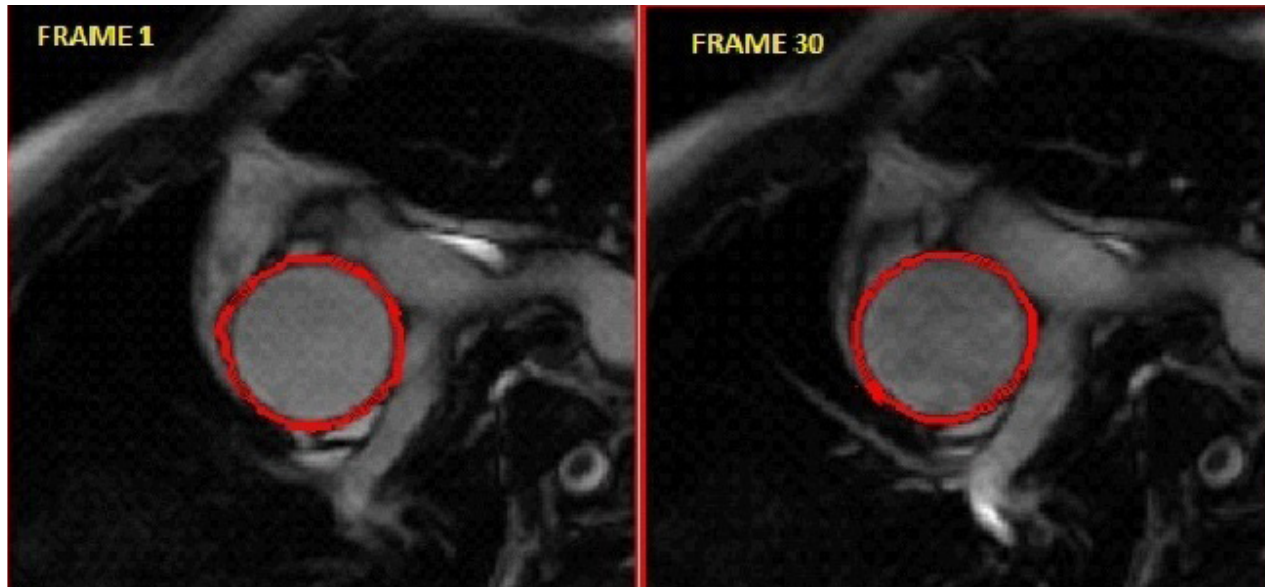
Fig. 1 – Manual processing of acquired magnetic resonance images showing first steady-state free-precession frame and the frame with the maximal cross-sectional area of the ascending